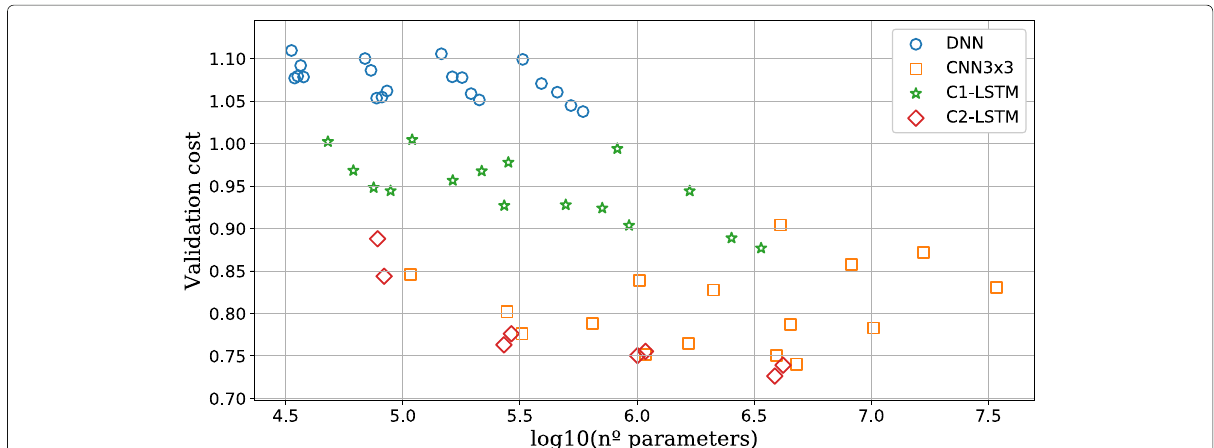
Fig. 8 Speech-music event detection validation cost across the evaluated models. Each point in the scatter plot represents one of the trained networks, and its position along the horizontal and vertical axes indicates the number of parameters (in a logarithmic scale) and the validation cost obtained,